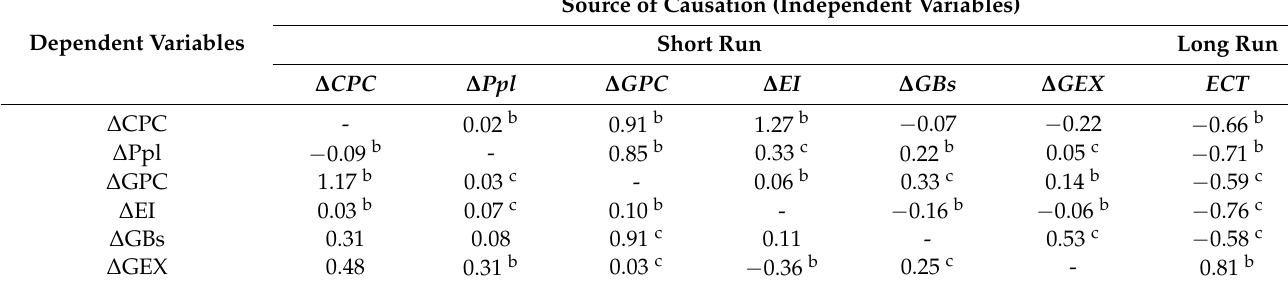
Table 9. Granger causality panel error correction test.